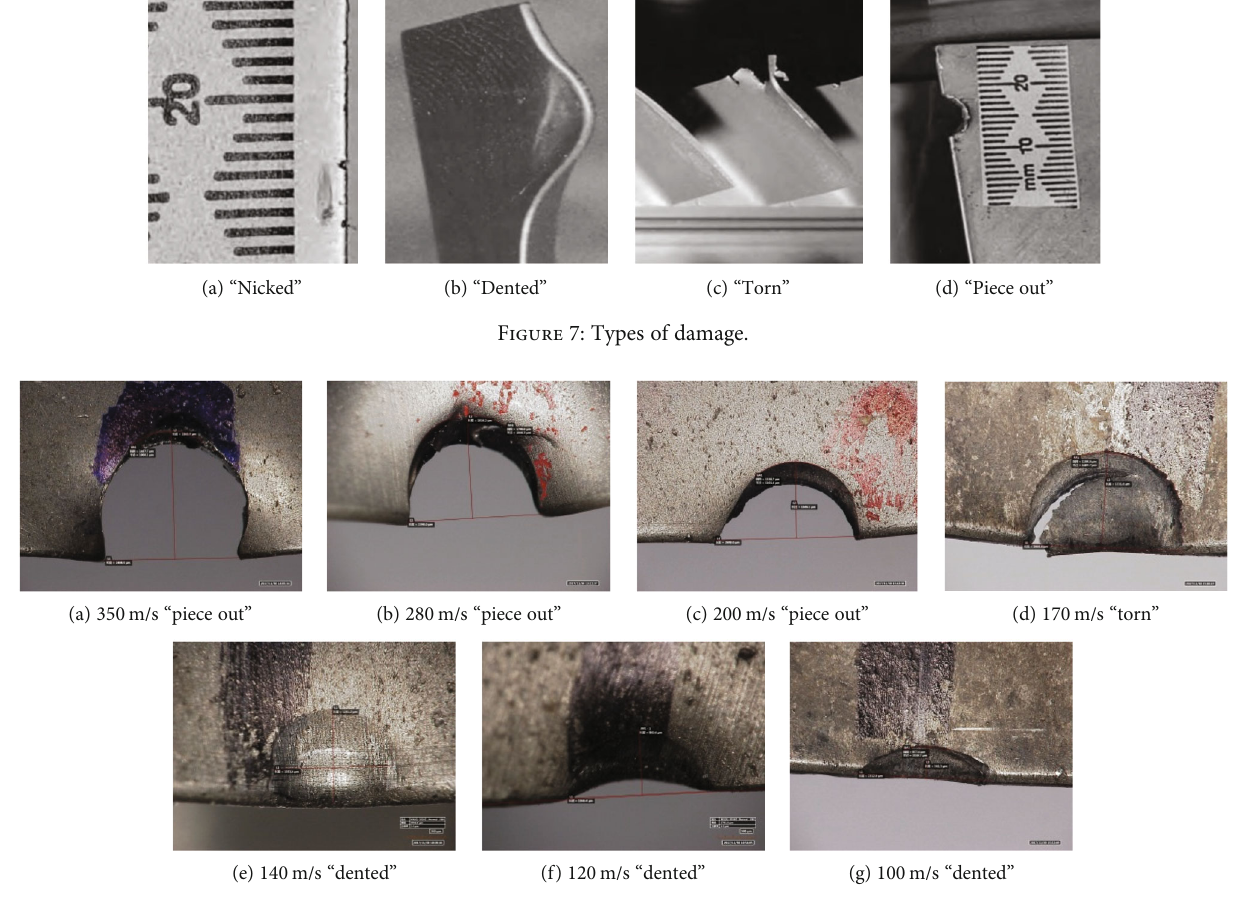
Figure 8: The typical damage of blade under 60 ° impacts.